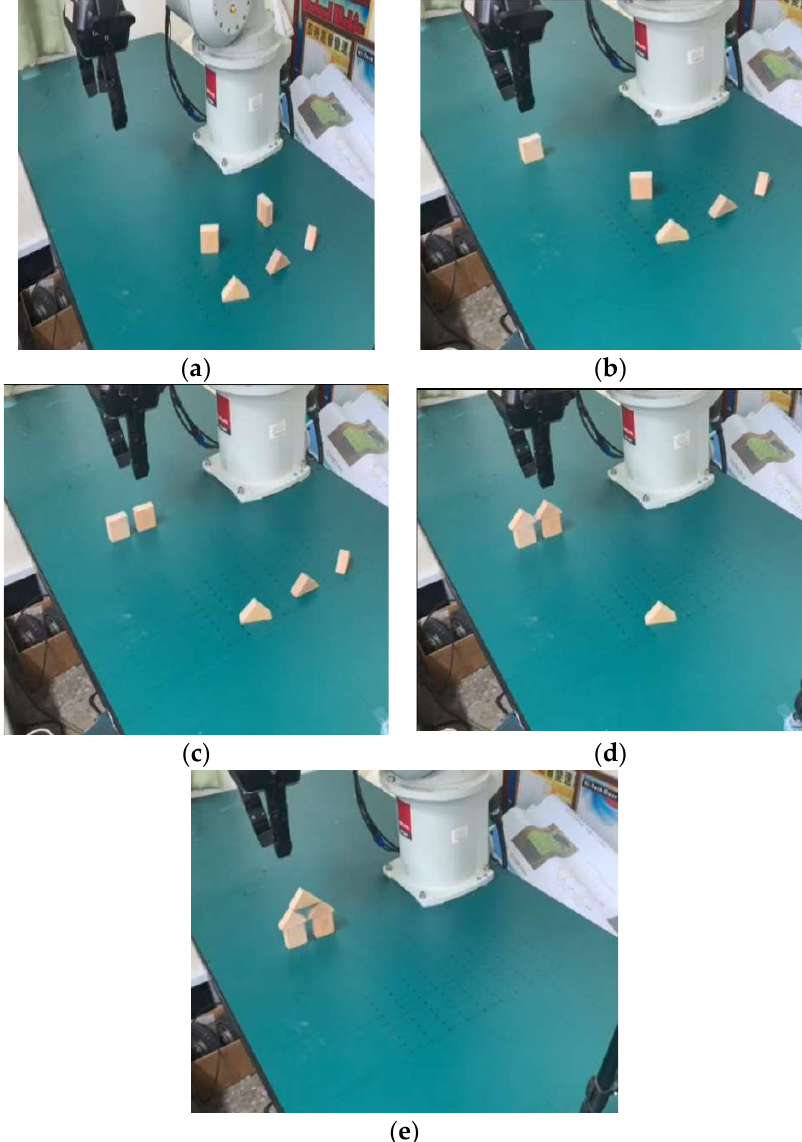
Figure 19. Operation process: ( a )–( e ) The second layout